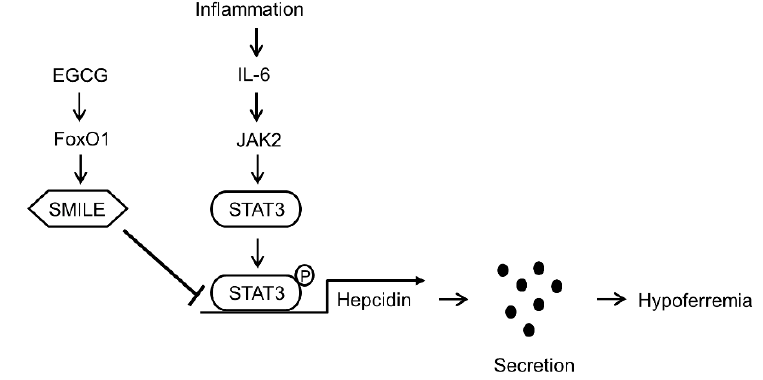
Figure 8. A model for SMILE function in IL-6-mediated hepcidin expression. SMILE expression is increased by EGCG-mediated induction of FoxO1 expression. In addition, SMILE expression inhibits STAT3 binding to hepcidin promoter and subsequently contributes to suppression of hepcidin production and secretion triggered by the IL-6 signal in